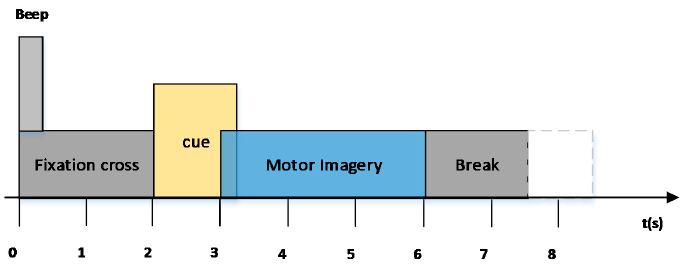
Figure 2. Timing scheme of the paradigm for data set 2a from brain–computer interface (BCI) competition 2008 [17].